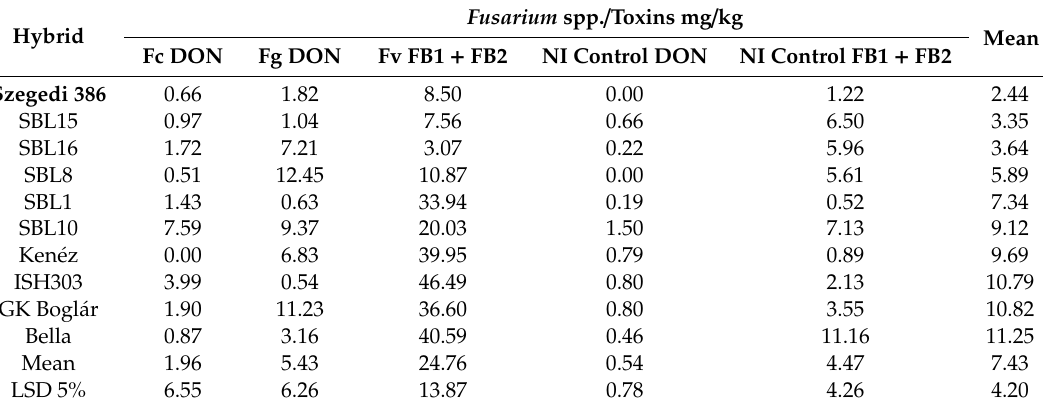
Table 12. Toxin contamination of the ten selected 10 hybrids against Fusarium spp. after toothpick inoculation (KR), Szeged, 2010–2012.